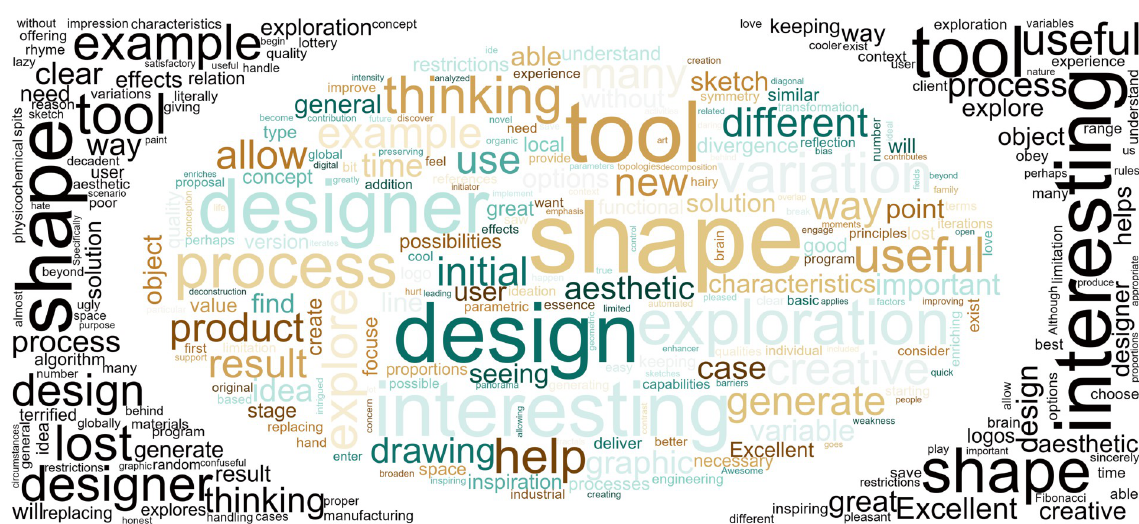
Fig 22. Word Clouds produced with the open feedback from the survey using all sentences (center), only the 20 most negative sentences (left), and the 20 most positive